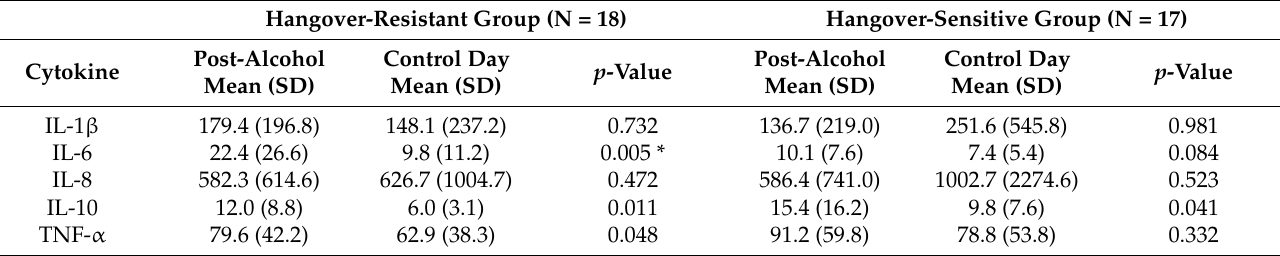
Table 3. Mean (SD) saliva cytokine concentrations.